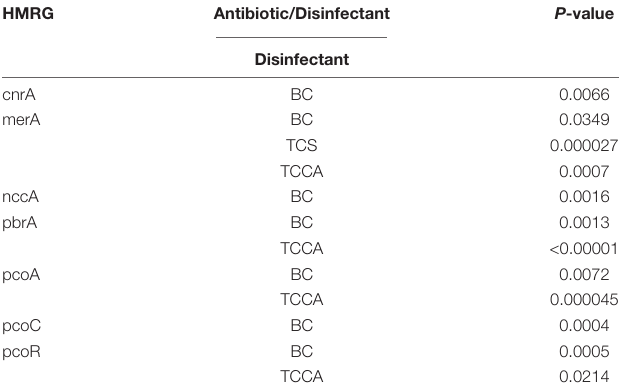
Frontiers in Microbiology |